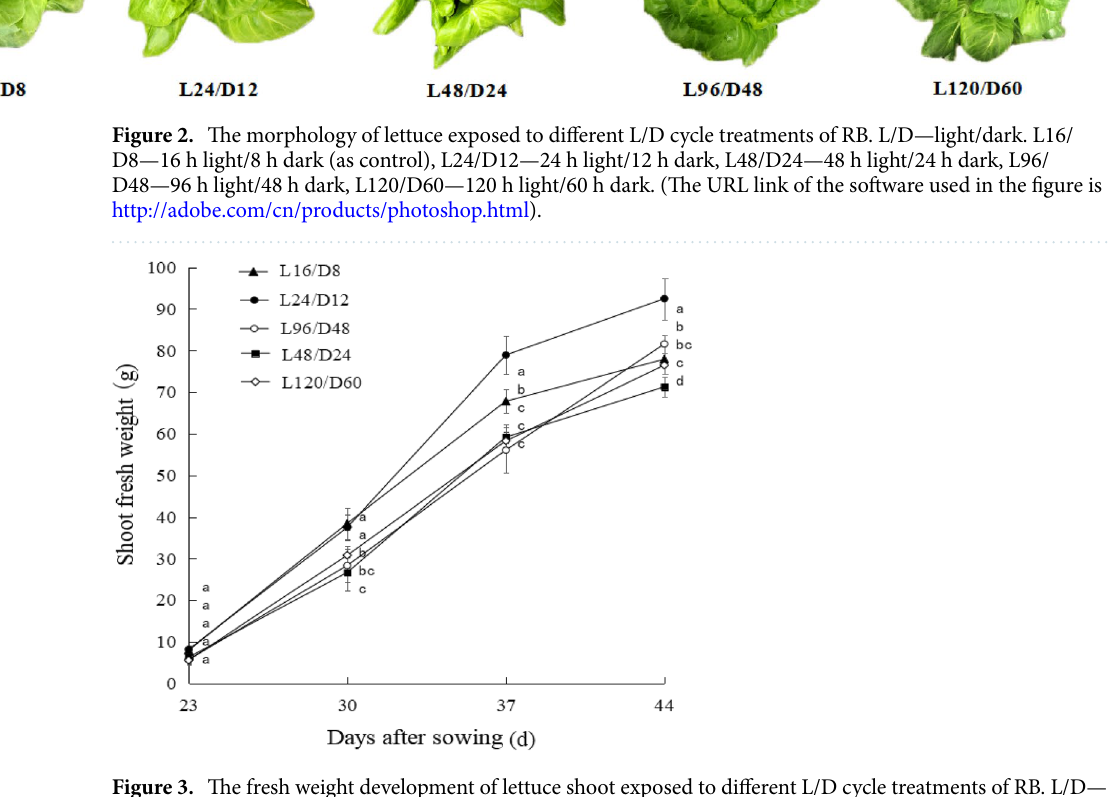
Figure 3. The fresh weight development of lettuce shoot exposed to different L/D cycle treatments of RB. L/D— light/dark. L16/D8—16 h light/8 h dark (as control), L24/D12—24 h light/12 h dark, L48/D24—48 h light/24 h dark, L96/D48—96 h light/48 h dark, L120/D60—120 h light/60 h